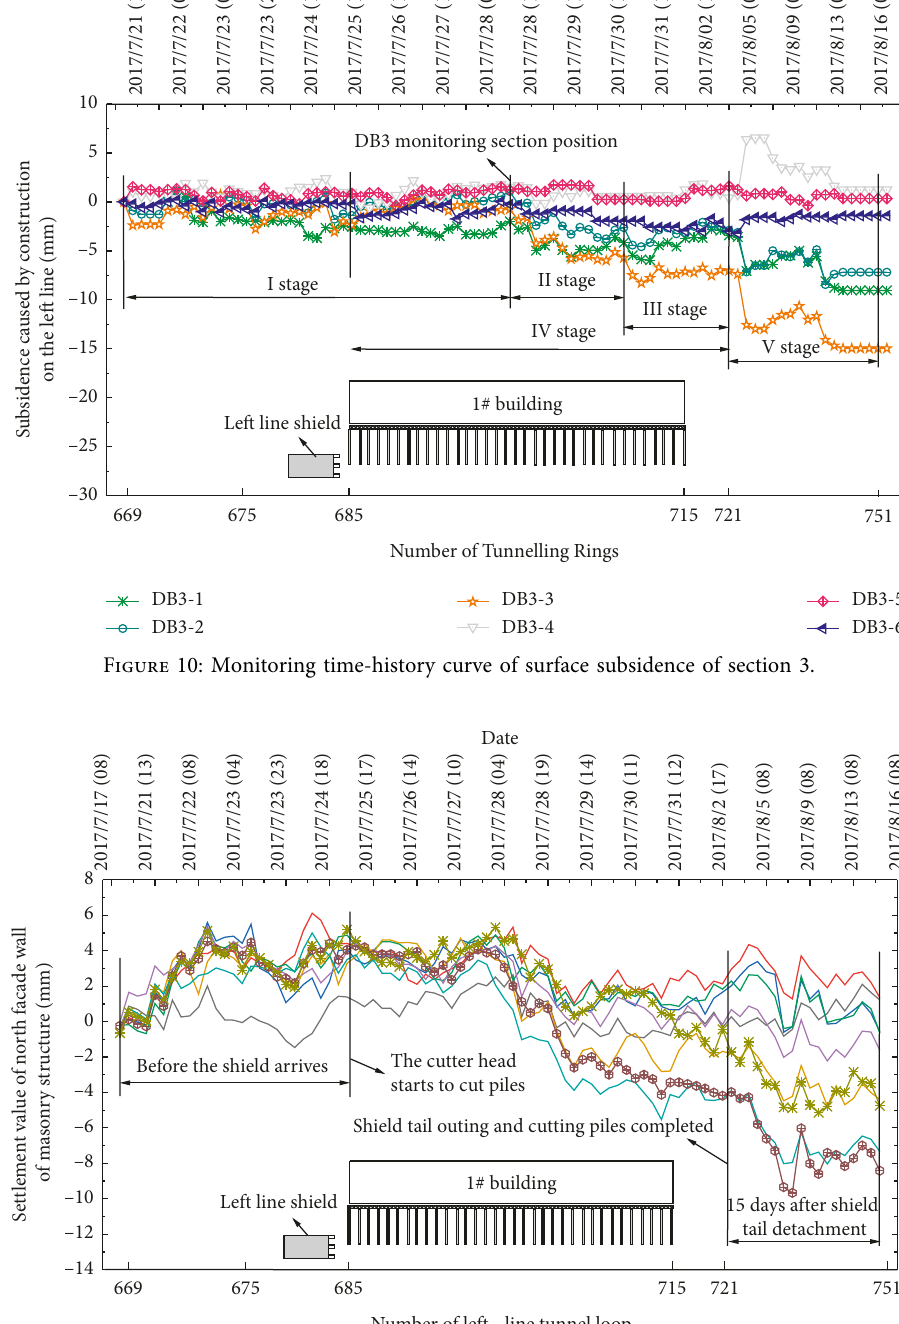
15 days after shield tail